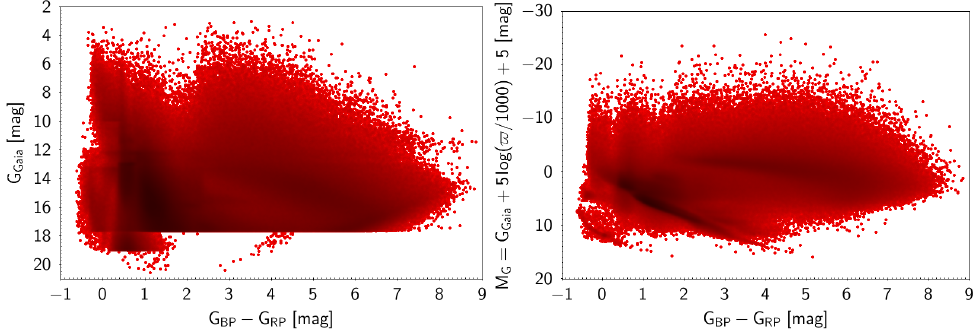
Figure 2. Magnitude-colour diagrams for sources with phot_variable_flag=’VARIABLE’ (excluded from our study) with continuous XP spectra in Gaia DR3 using the apparent ( left ) and absolute ( right ) magnitude.